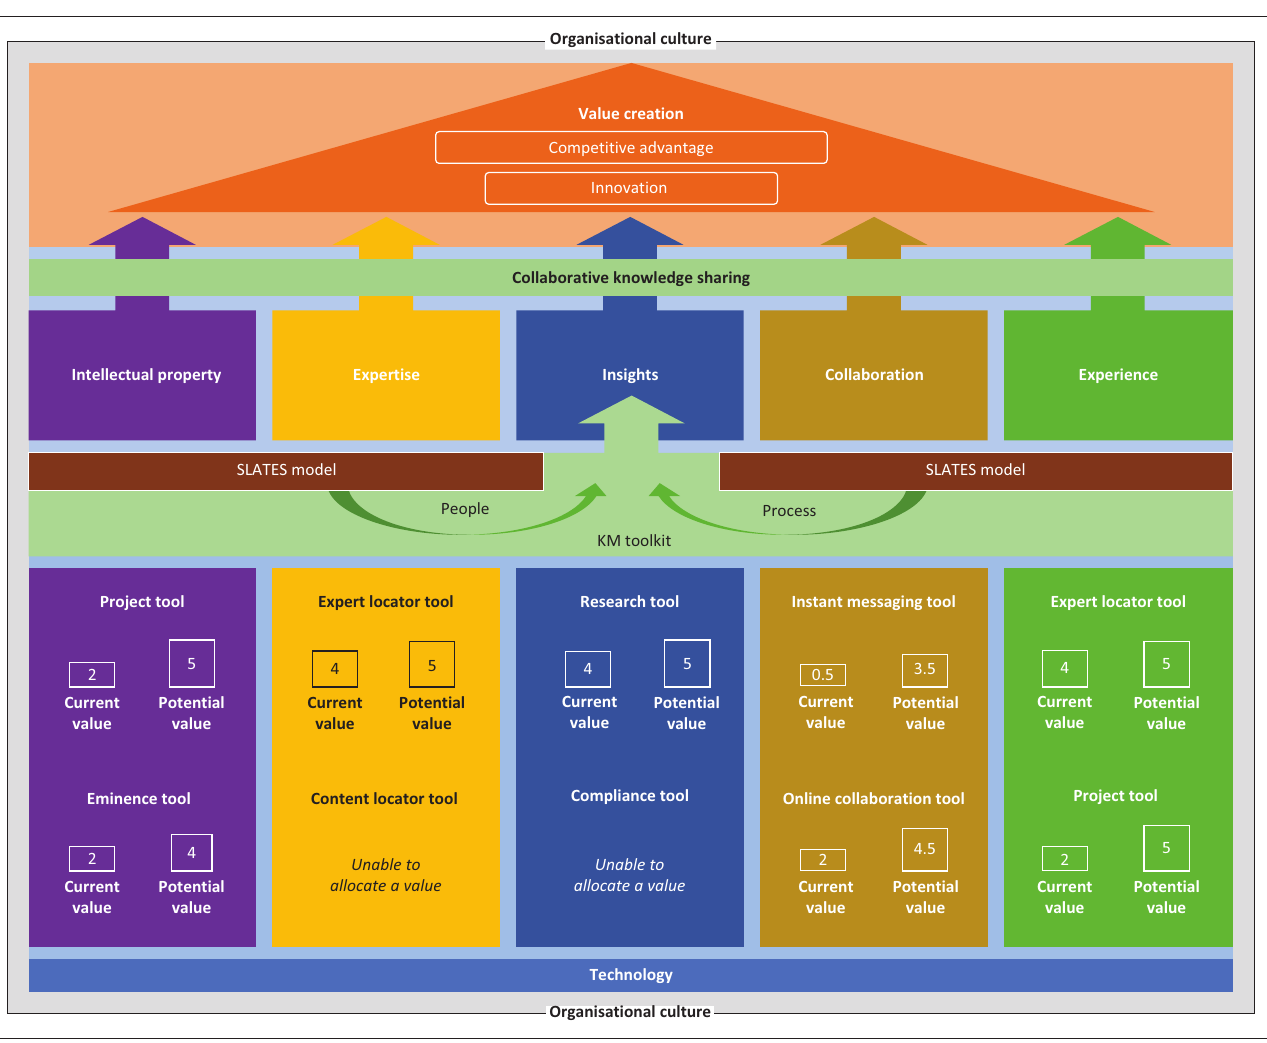
FIGURE 2: Current value and potential value of tools in the knowledge management